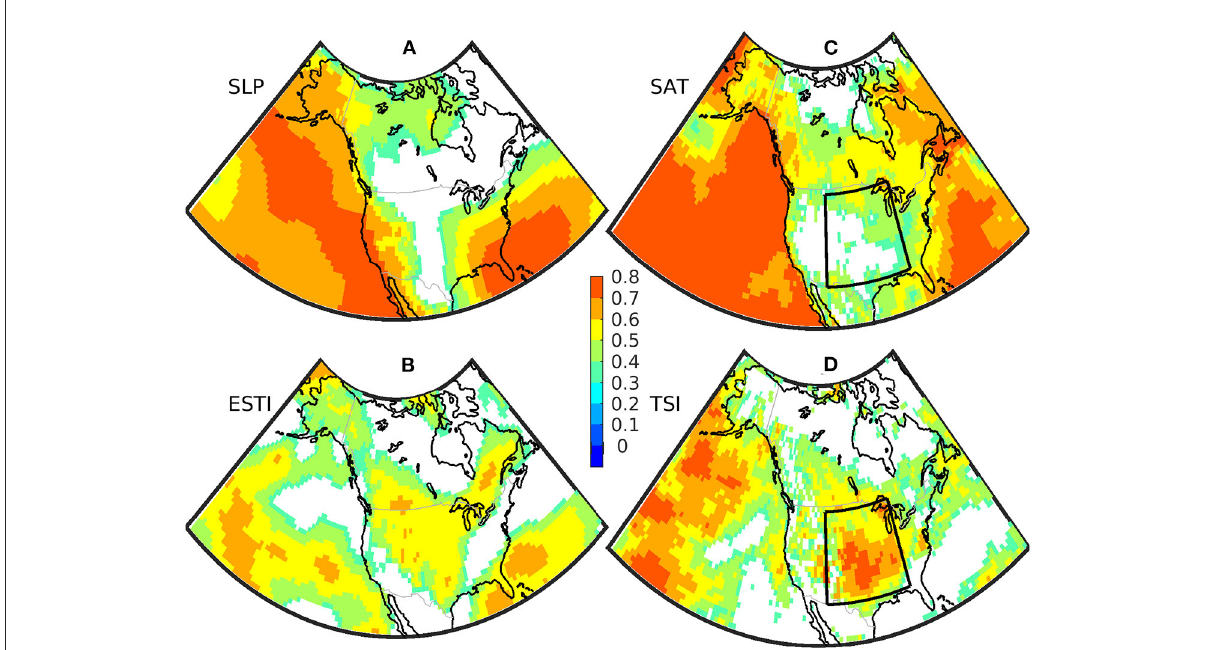
FIGURE4 The anomaly correlation coefficient (ACC) between SPEAR’s Seasonal Retrospective Forecasts (SRF) and ERA5 for the DJF mean (A) SLP, (B) Extratropical Storm Track Index (ESTI), (C) SAT, and (D) TSI, respectively. ACC values with the statistical p -value larger than 0.05 are not shown. SRF are initialized on 1 st December during